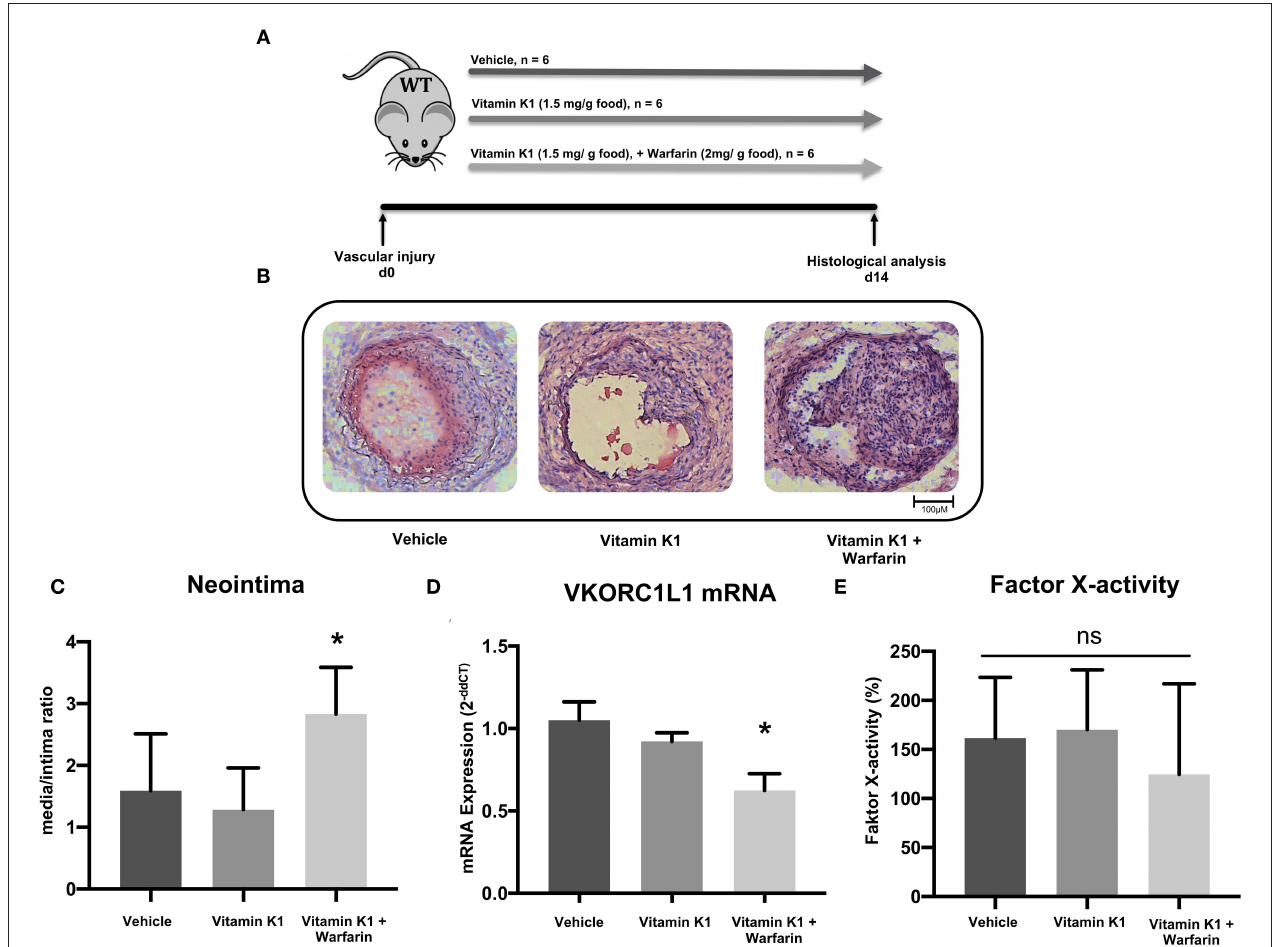
FIGURE 1 | Vitamin K antagonism promotes vascular remodeling. (A) Schematic diagram of the design of the carotid artery injury experiment. After the procedure on 6–8 week-old C57Bl/6J wild-type mice, they were randomized in three groups that received either vehicle (group A), vitamin K1 (1.5 mg/g food)-enriched diet (group B), or vitamin K1 (1.5 mg/g food) and warfarin (2 mg/g food)-enriched diet (group C), n = 6 per group. (B) Images of neointima formation 14 days after carotid artery injury. Vessels were subjected to histological analysis by H.E. staining. (C) Quantitative assessment of neointima formation expressed as the media/intima ratio. (D) VKORC1L1 mRNA expression in the abdominal aorta expressed as 2 − ddCT relative to control. (E) Factor X activity measured in citrate plasma samples after 14 days of treatment. Data are presented as the mean ± SEM; * p < 0.05; one-way ANOVA + Bonferroni’s multiple comparison test for (C-E)